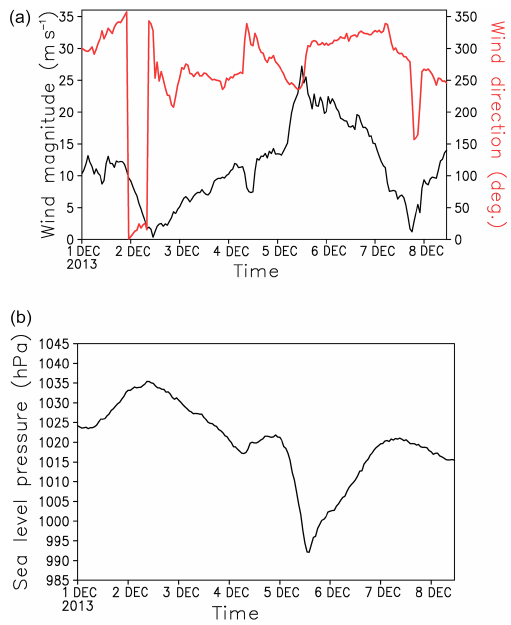
Figure 2. Meteorological situation at the Elbe station (see Fig. 1 for its location) during Xaver from DWD data. (a) 10m wind mag- nitude (black line) and wind direction (red line), (b) atmospheric pressure.